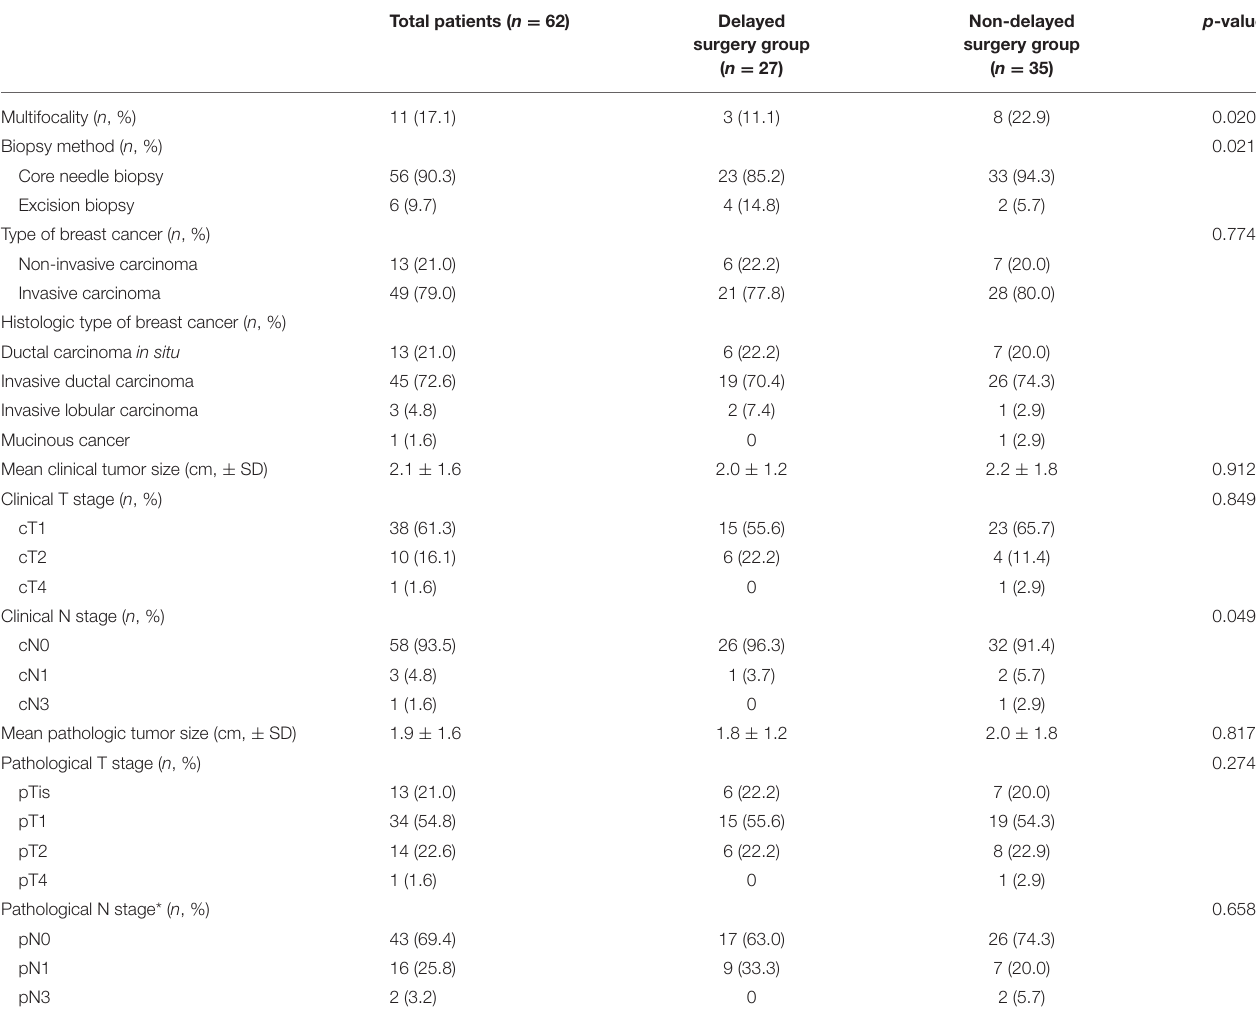
TABLE 2 | Disease characteristics of patients with breast cancer who underwent surgery during the COVID-19 outbreak.